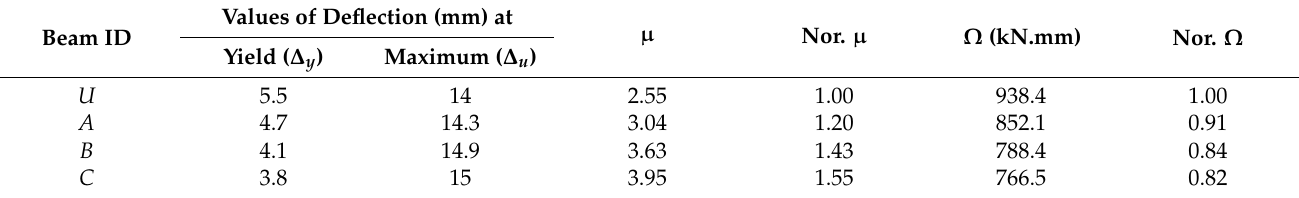
Table 2. Results for